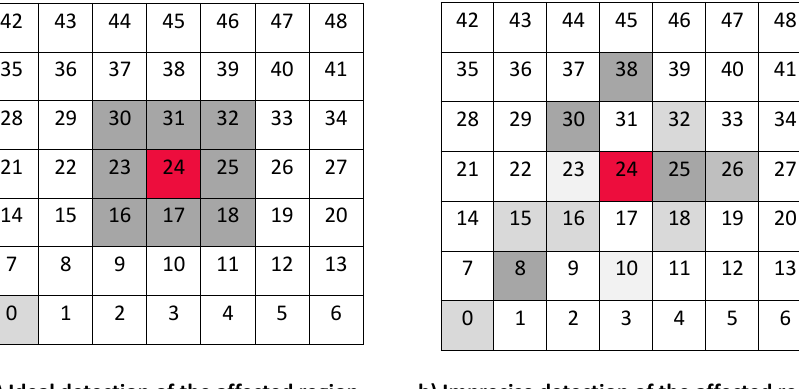
Figure 13. Difference between ideal detection and imprecise detection of a jammer node.